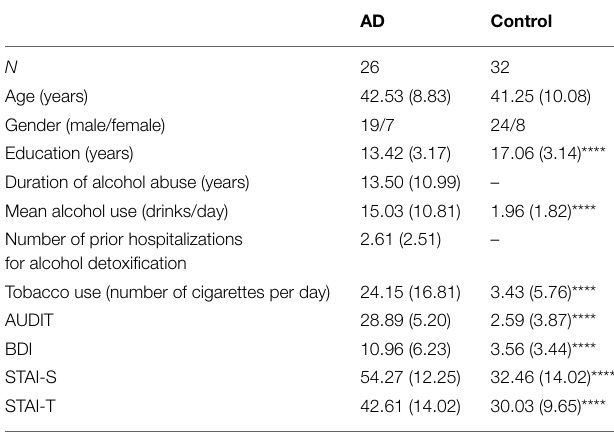
TABLE 1 | Demographic data means and standard deviations for the alcohol-dependents (ADs) and